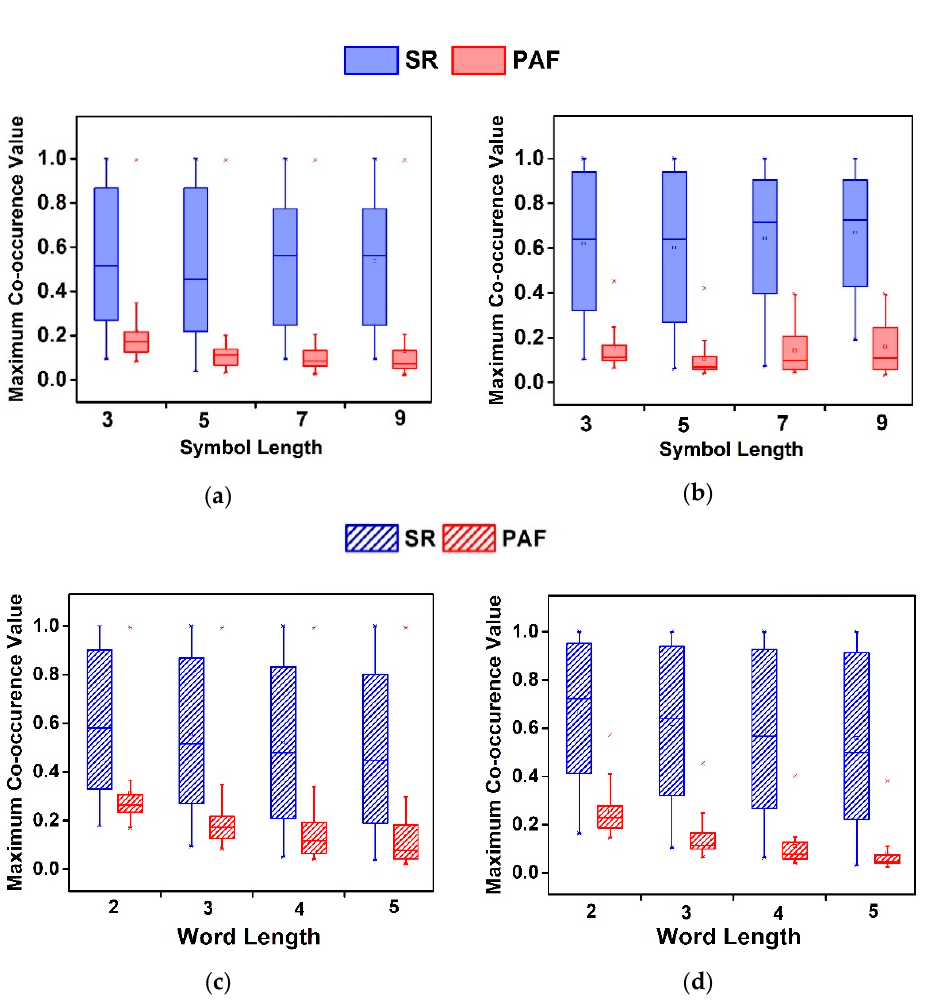
Figure 7. Boxplots representing the distribution of maximum co-occurrence values for varied |𝕍| with 𝑊 = 3 and for varied 𝑊 with |𝕍| = 3 in AFPDB ( a , c ) and AFTDB ( b , d ). For AFPDB, the top three parameters: |𝕍| = 9, 7 , and 5 with 𝑊 = 3 obtained F